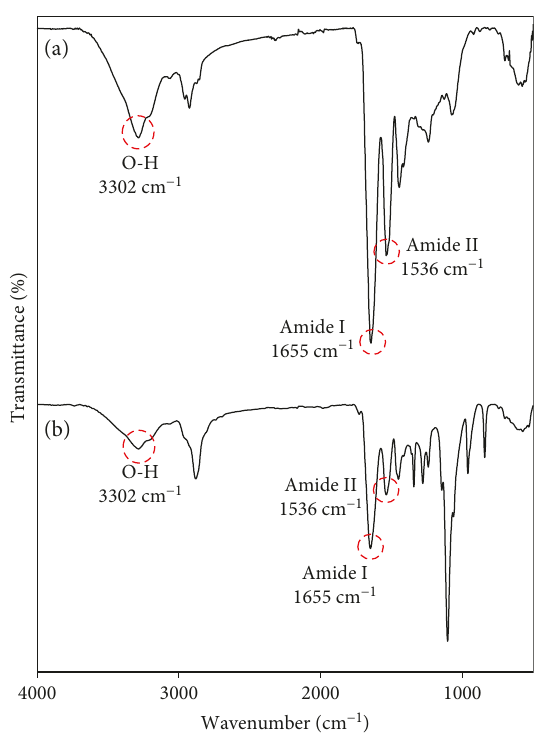
Figure 6: Fourier transform infrared (FTIR) spectra of (a) wheat- gluten proteins soluble in ethanol (WGPSE) (gliadins, mainly) and (b) WGPSE